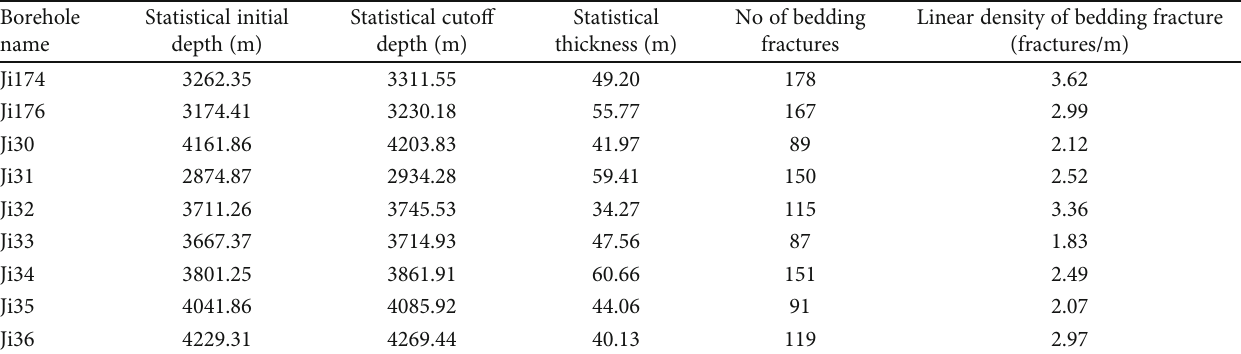
Table 2: Statistic of linear density of bedding fractures in the lower sweet spot of Lucaogou formation in Jimsar sag.